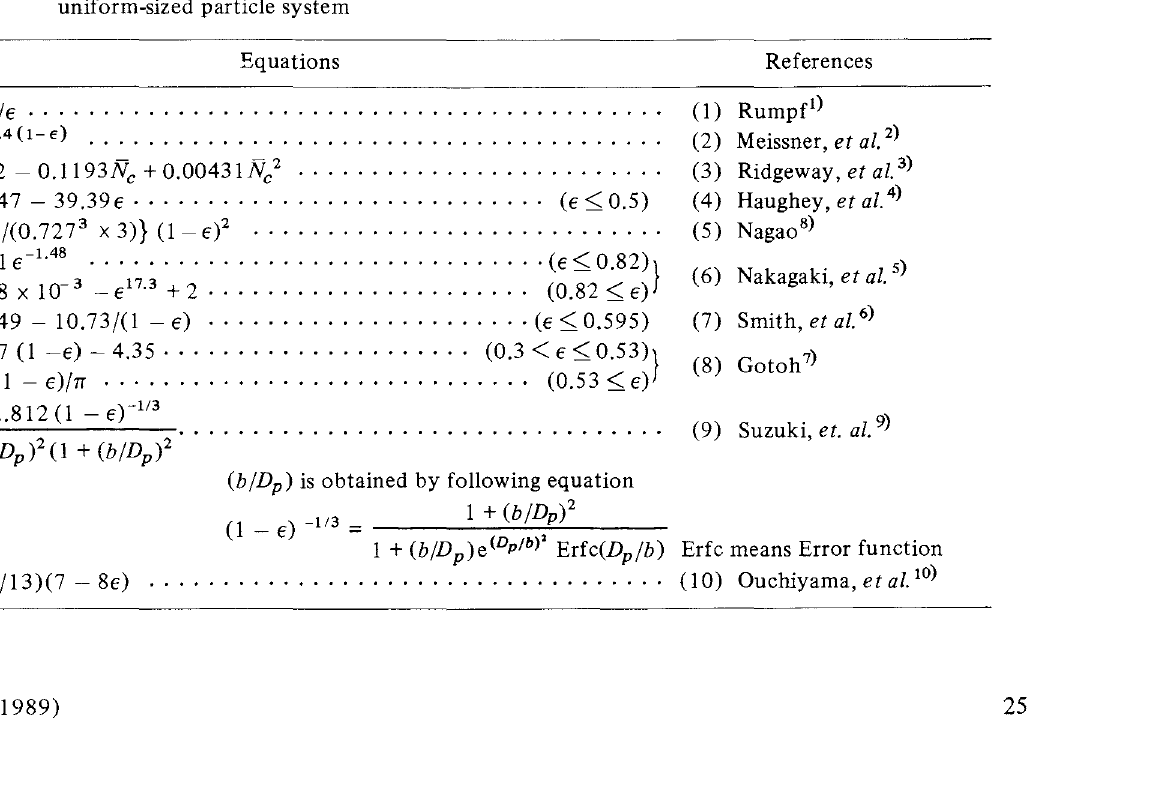
Table 1 Equations for relation between average coordination number and void fraction in uniform-sized particle system